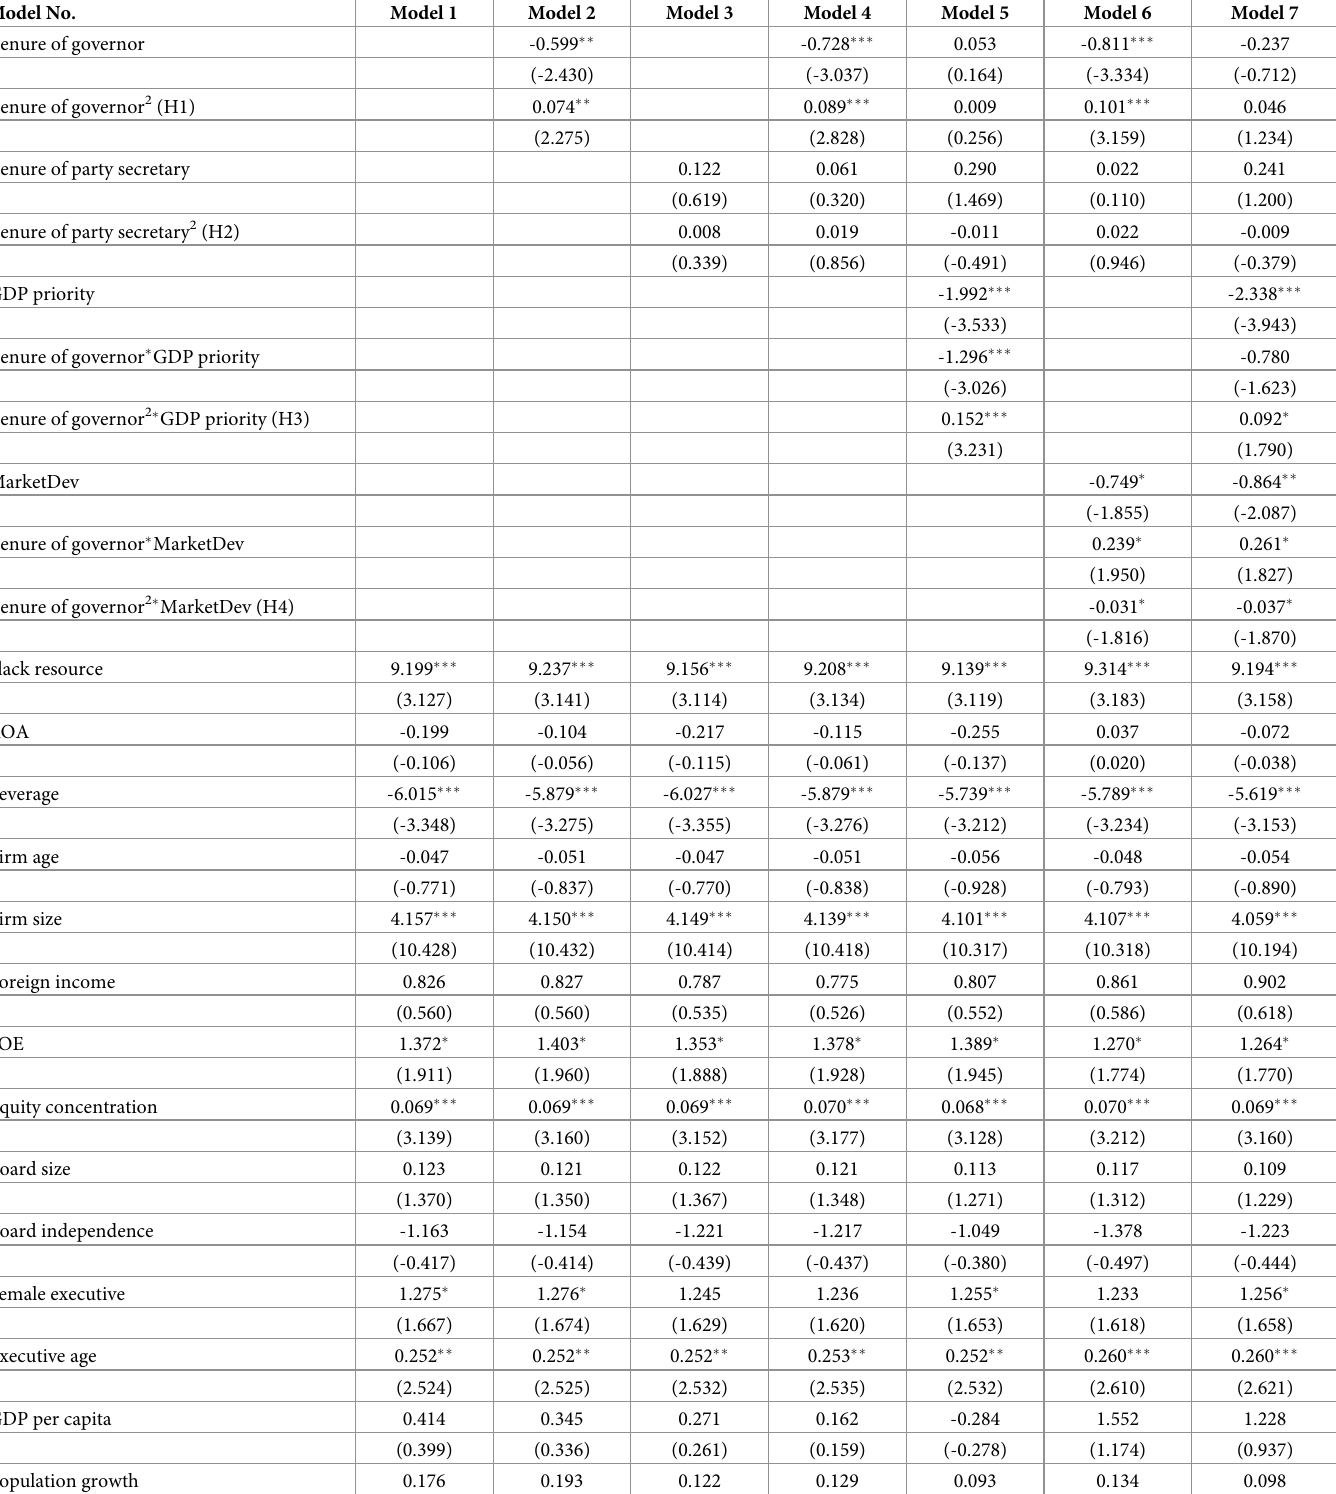
Table 4. Effects of government leaders’ tenure on CSR and moderating effects of GDP priority and regional market development (Heckman second-stage model). Model